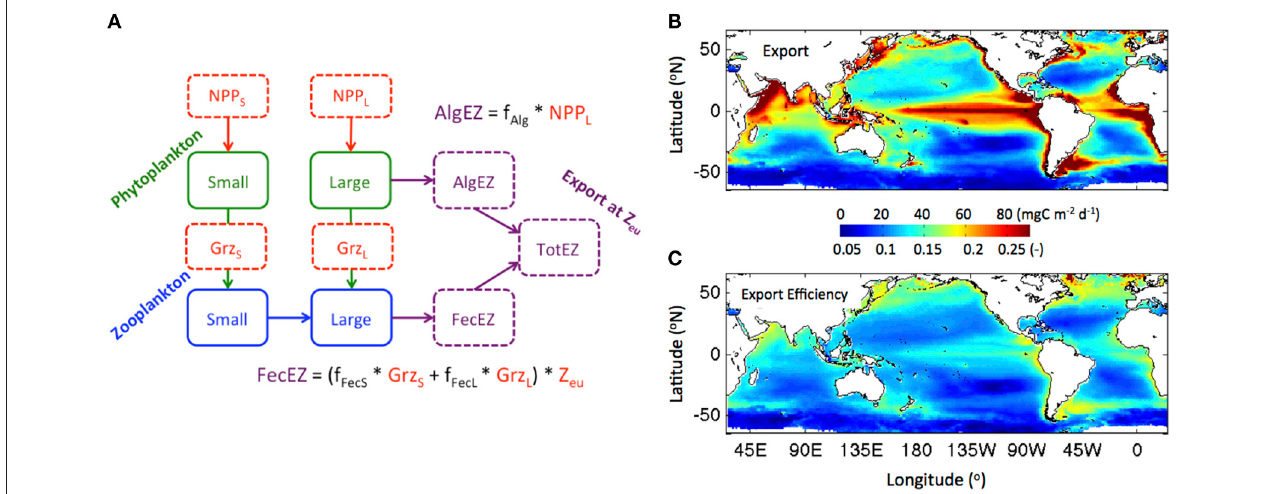
FIGURE 3 | Model schematic and results from a satellite-data driven food-web export flux model. (A) Food-web export flux model illustrates how NPP energy is routed to export either through sinking of large phytoplankton or as fecal material. Solid boxes indicate stock abundances while dashed boxes are fluxes. (B) Determination of annual export flux from the euphotic zone and (C) export efficiency ( = export/NPP). Figure is adapted from Siegel et al.